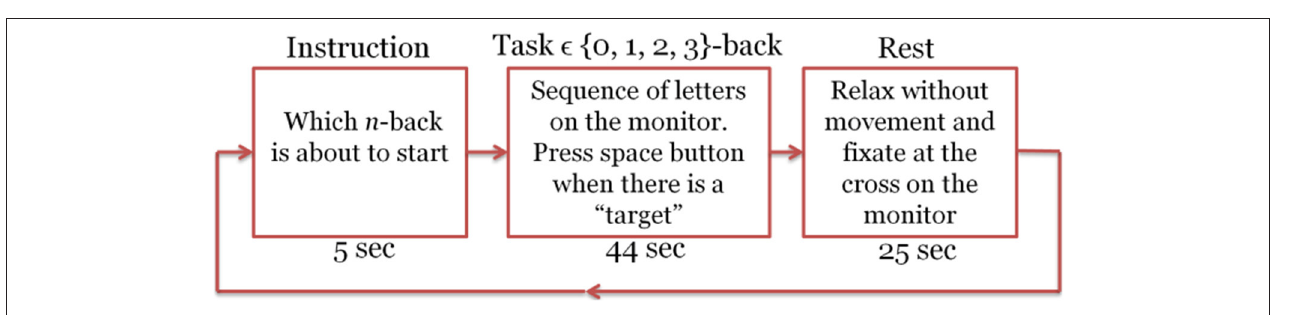
FIGURE 2 | Experimental design for the letter n -back task. Each session includes the Instruction, task, and rest